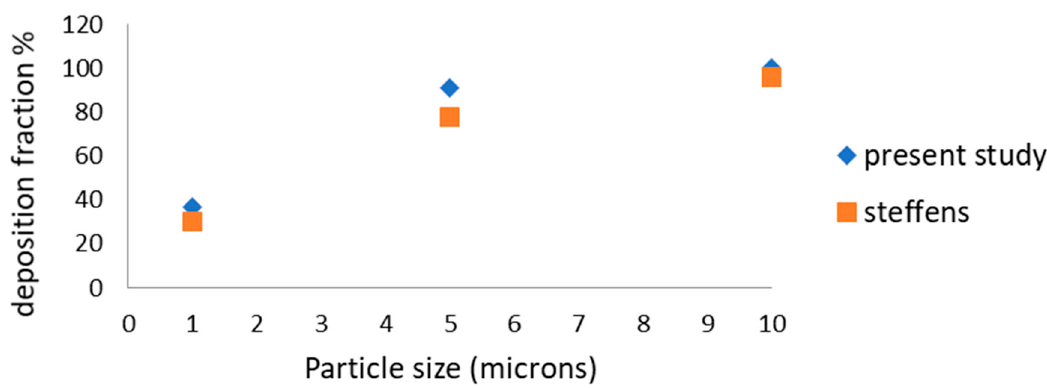
Figure 6. Total deposition fraction % at constant